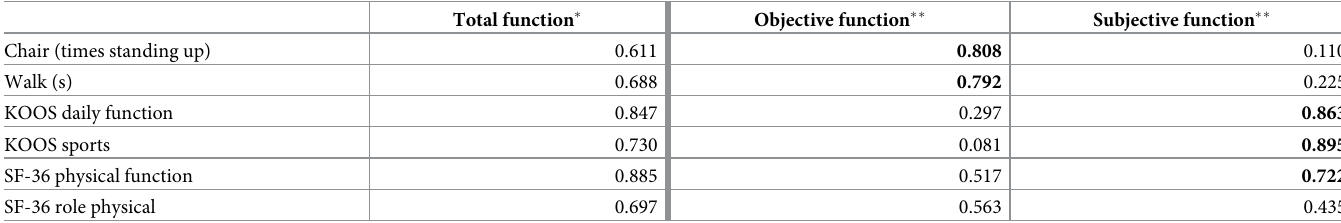
Table 1. Principal component analysis function outcome